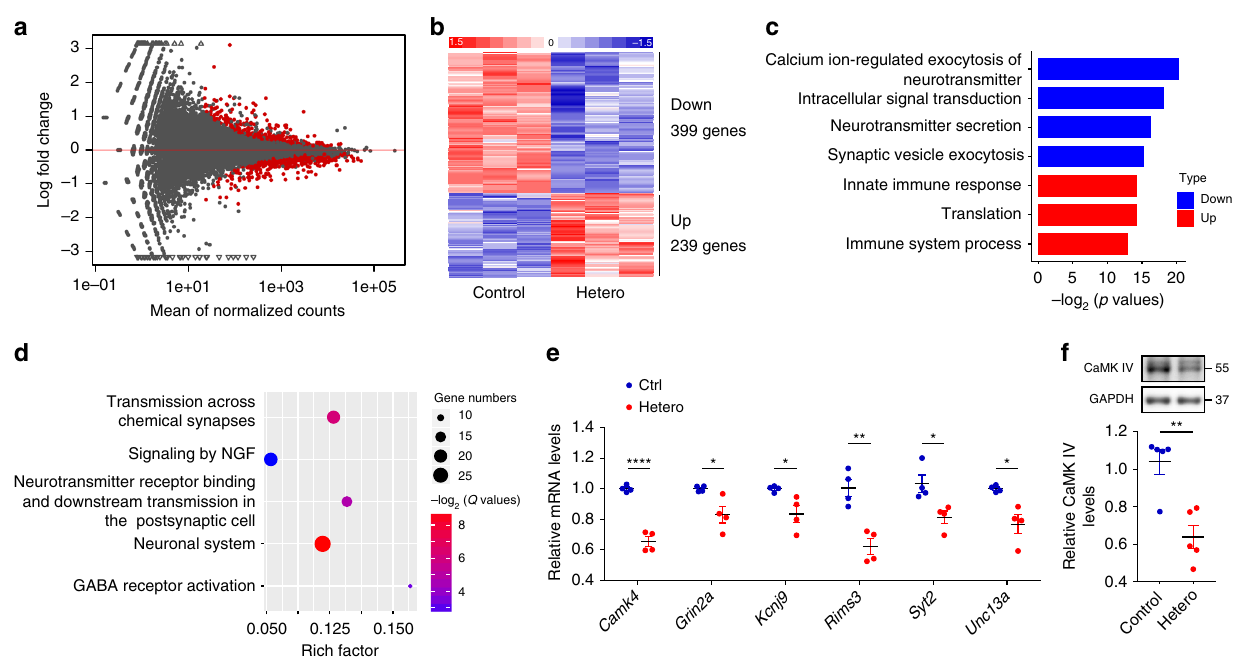
Fig. 7 GFP-PR 28 expression is associated with synaptic transmission-related genes dysregulation. a MA-plot of differentially expressed genes in the cerebellum of 5-month-old control and GFP-PR 28 heterozygous mice. Red blots indicate signi fi cant changes, n = 3, 3 mice. b Hierarchical clustering of differentially expressed genes in the cerebellum of 5-month-old control and GFP-PR 28 heterozygous mice. c Gene ontology (GO) biological processes analyses of upregulated and downregulated genes in ( b ). d The Reactome pathway analyses of top fi ve enriched terms of downregulated genes in ( b ). Gene numbers indicate genes that are enriched in this pathway. Rich factor indicates the ratio of enriched genes to total genes in this pathway. e Relative mRNA expression of six genes ( Camk4, Grin2a, Kcnj9, Rims3, Syt2, and Unc13a ) in association with synaptic transmission in the cerebellum of 5-month-old control and GFP-PR 28 heterozygous mice. Two-tailed t test, n = 4, 4 mice. f Relative expressing levels of CaMK IV in the cerebellum of 6-month-old control and GFP-PR 28 heterozygous mice, determined by western blotting assay. Two-tailed t test, CaMK IV, n = 5, 5 mice. All data are displayed as mean ± s.e.m. * P < 0.05, ** P < 0.01, **** P <